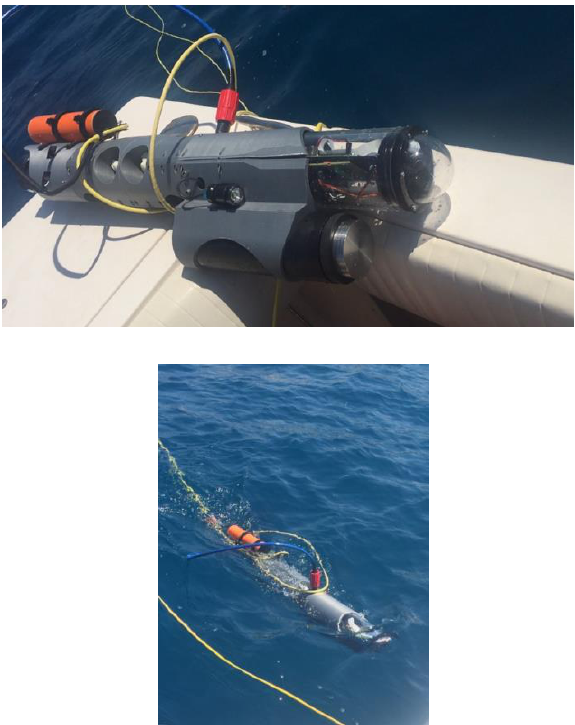
Figure 5. Experimental ROV used in the survey